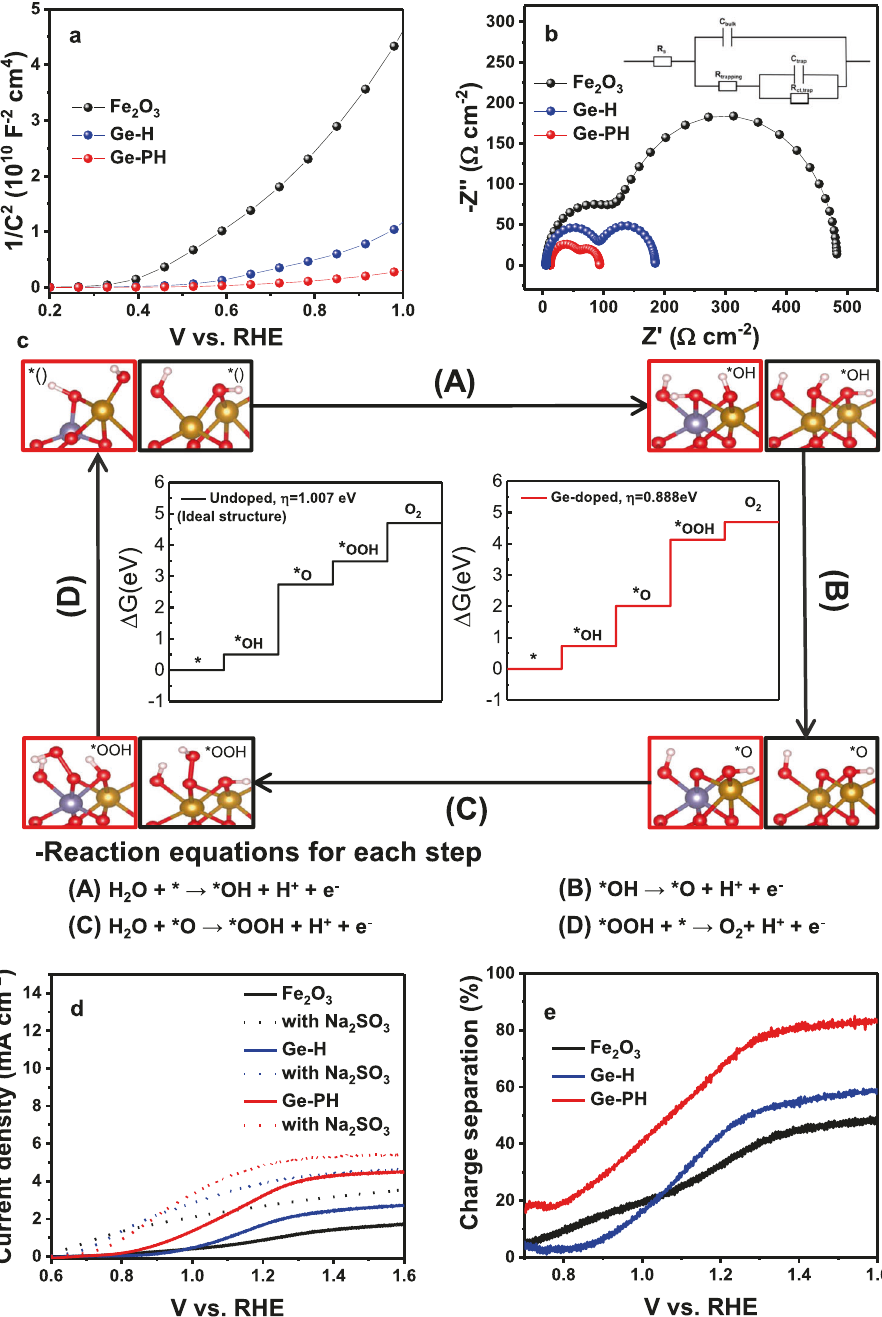
Fig. 4 Electrochemical analysis and simulated OER activity. a Mott-Schottky plots and b EIS measurements (with the circuit model). c Free energy diagrams of the intermediates on Fe 2 O 3 (undoped) and Ge-Fe 2 O 3 (Ge-doped). For comparison, the free energies of the OER species on the hematite (0001) surface from the literature are included. Brown, gray, red, and white are Fe, Ge, O, and H atoms, respectively. d LSV curves of Fe 2 O 3 , Ge-H, and Ge- PH under illumination in 1 M NaOH (solid line) and a solution mixture of 1 M NaOH and 0.5 M Na 2 SO 3 (dashed lines). e Charge separation ef fi ciencies. Table 1 Representative results for the fl at band potential (EFB), charge carrier concentration (ND), and space charge width (Wsc) from Mott-Schottky